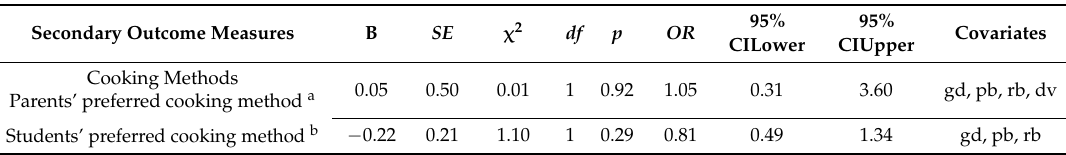
Table 7. Estimates of students’ and their parents’ preferences of cooking methods at home in complex sample binary logistic